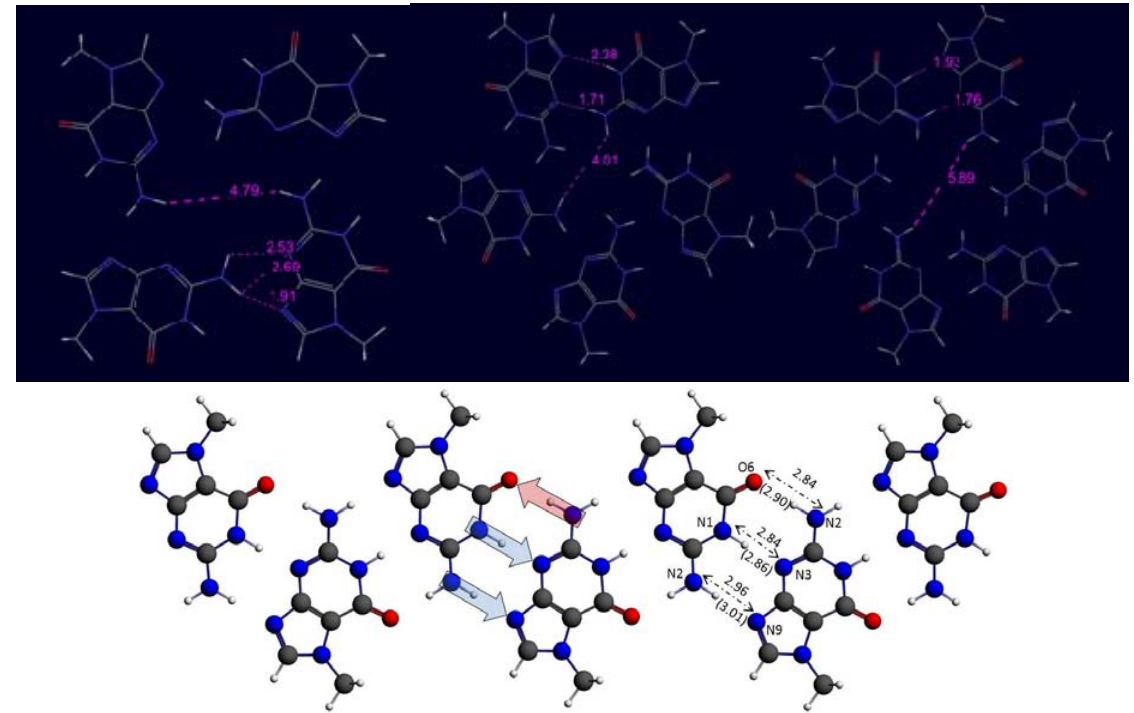
Figure 3. Optimized planar ring and ribbon structures of m 7 G with selected distances (in Å). The numbers in parenthesis show the corresponding distances in 7 H -guanine crystal [17]. The hollow arrows represent the D  H···A hydrogen bonding